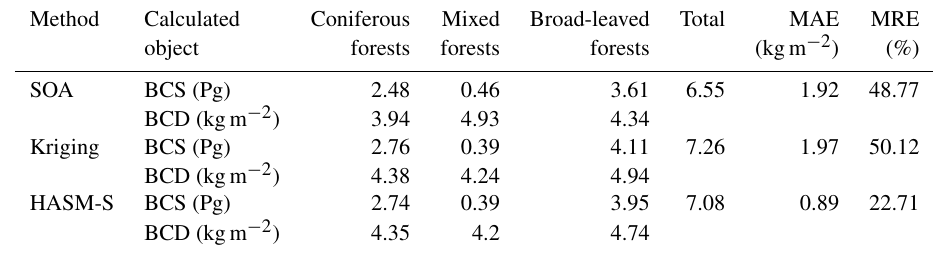
Table 1. Biomass carbon stocks and biomass carbon densities as well as their errors produced by different methods.